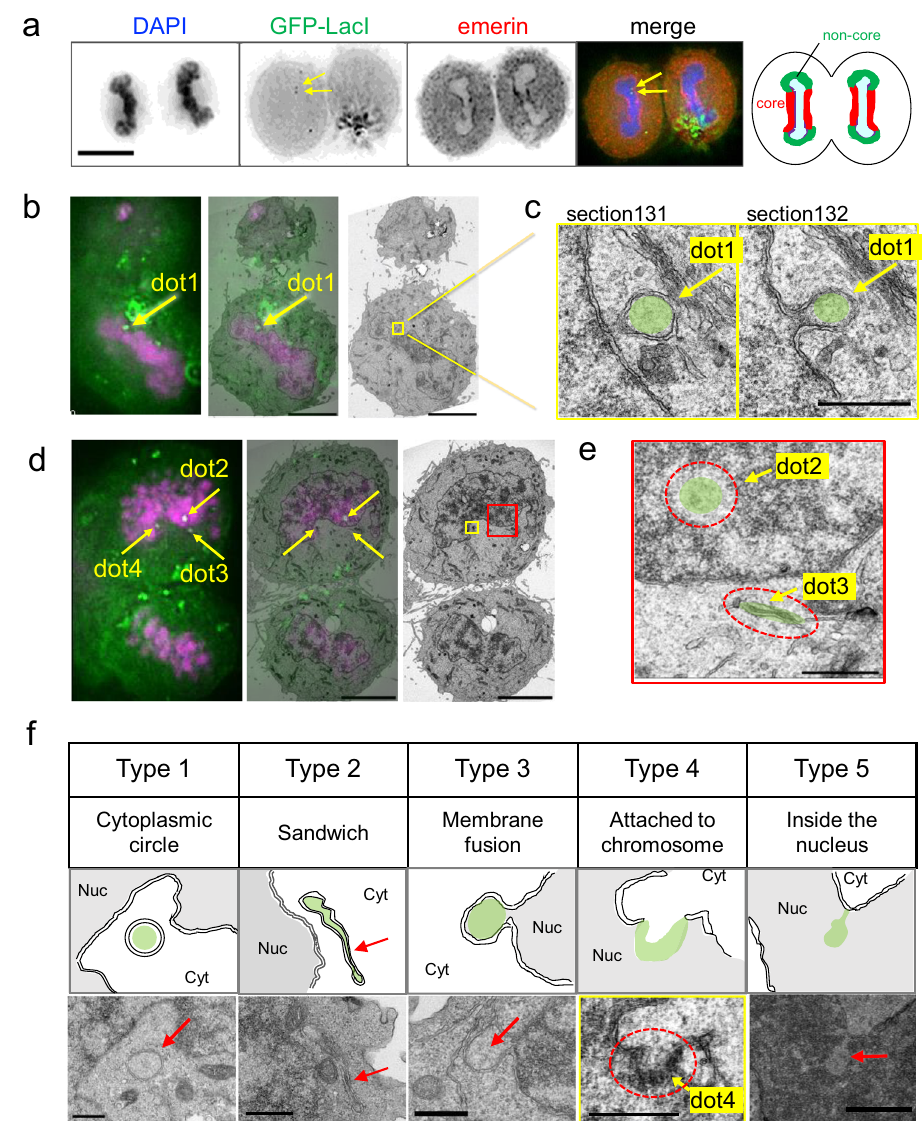
Fig. 3 CLEM images showing small puncta of transfected DNA in telophase cells. HeLa/GFP-LacI cells were transfected with pLacO-pEF1 α -RFP, and then fi xed and subjected to indirect immuno fl uorescence imaging ( a ) or CLEM ( b – f ). a Indirect immuno fl uorescence images of telophase cells. After the removal of the transfection reagent, the cells were fi xed and immunostained for emerin. DAPI (DNA, blue), GFP-LacI (green), and emerin (red) are shown in the merged image. The rightmost cartoon illustrates the “ core ” (red) and “ non-core ” (green) regions of the NE, forming around the telophase chromosome mass. Bars, 10 μ m. b Representative CLEM images of telophase cells. Left, fl uorescence microscopic image; middle, merged image; right, electron microscopic image. Colors represent GFP-LacI (green) and DAPI (magenta). Arrows indicate the position of GFP-LacI (dot 1). Bar, 5 μ m. c Higher magni fi cation of the yellow-boxed region in b . Arrows indicate the positions of GFP-LacI (dot 1, shaded in green). Section131 and section132 are the neighboring sections, 80 nm apart. Bar, 500 nm. d Different focal planes of the cell shown in b . Left, fl uorescence microscopic image; middle, merged image; right, electron microscopic image. Colors represent GFP-LacI (green) and DAPI (magenta). Arrows, positions of GFP-LacI (dots 2 – 4). Bar, 5 μ m. e Higher magni fi cation of the red-boxed region in d . Red circles represent the regions of the fl uorescence signals, shaded in green. Bar, 500 nm. f Classi fi cation of puncta morphologies. Type 1 (cytoplasmic circle): plasmid contained within a circular (or spherical) structure surrounded by an NE-like membrane that is present in the cytoplasm. Type 2 (sandwich): plasmid is present between NE-like membranes. Type 3 (membrane fusion): plasmid contained in the cytoplasmic circle fused with the NE. Type 4 (attached to chromosome): plasmid attached to the telophase chromosomes. Dot 4 is the same dot 4 shown in d . Type 5 (inside the nucleus): plasmid inside the nucleus. Middle panels, schematics of the electron microscopic images. NE is shown as a double line. Red arrows indicate the positions of GFP-LacI, shaded in green. Electron microscopic images of wider areas, including the area shown in this fi gure, are shown in Supplementary Fig. 3. Bars, 500 nm for Types 1-4 and 1 μ m for Type